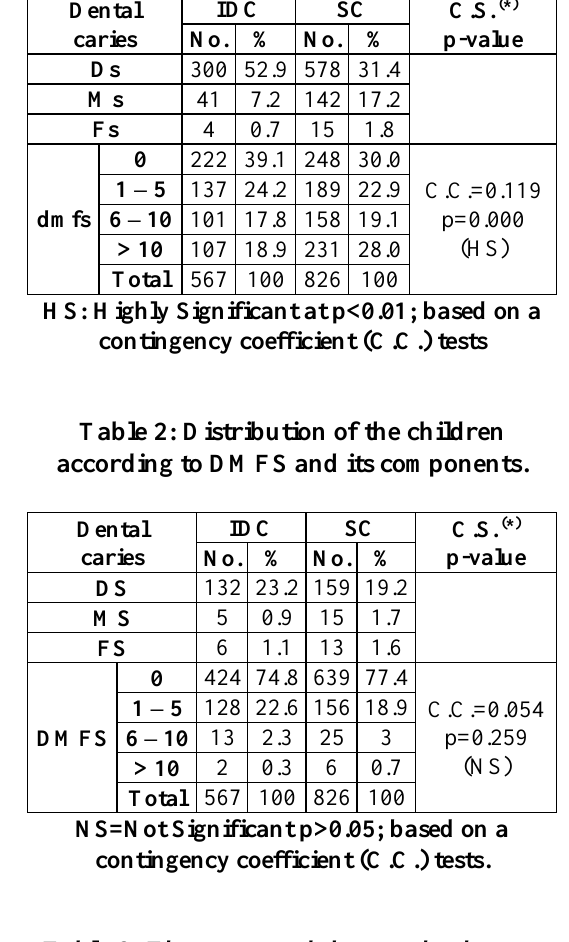
Table 3: The mean and the standard error of dental caries experience of the